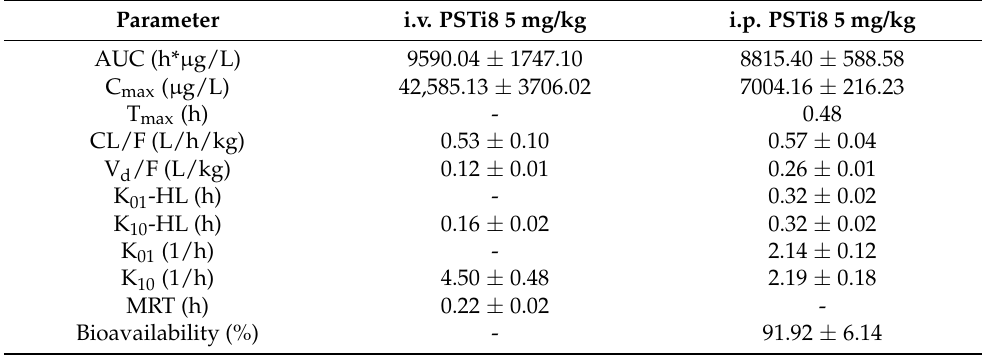
Table 4. Pharmacokinetic parameters of the PSTi8 peptide after i.v. and i.p. administration at 5 mg/kg in female SD rats. Data are presented as the mean ± SD with n =